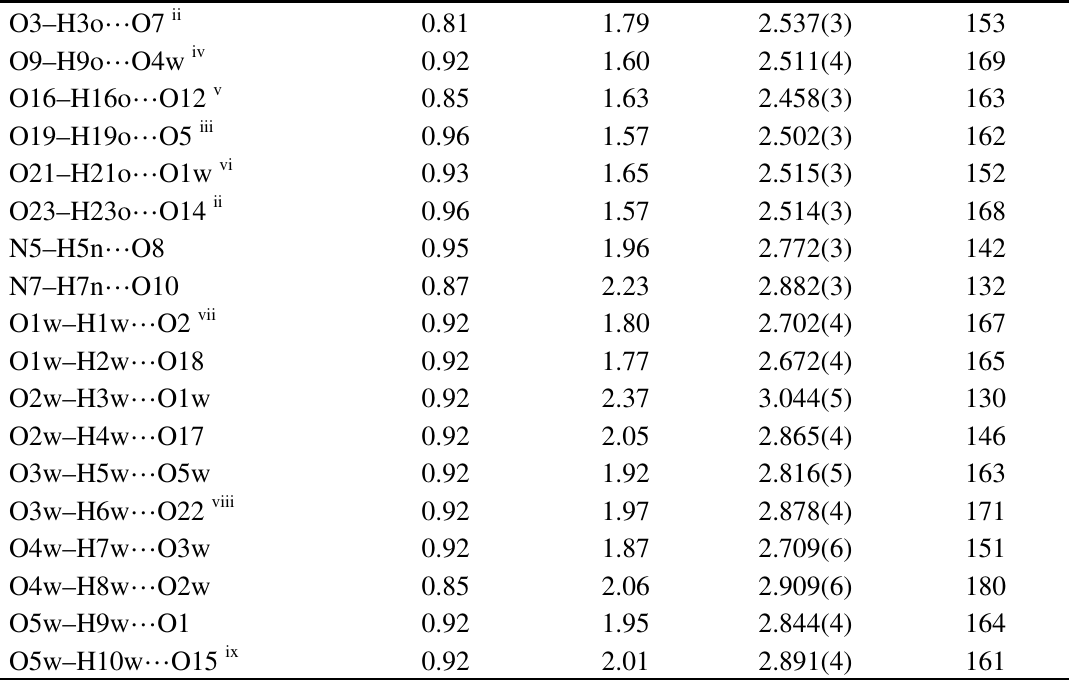
Table 2. Hydrogen-bond geometries for 1.